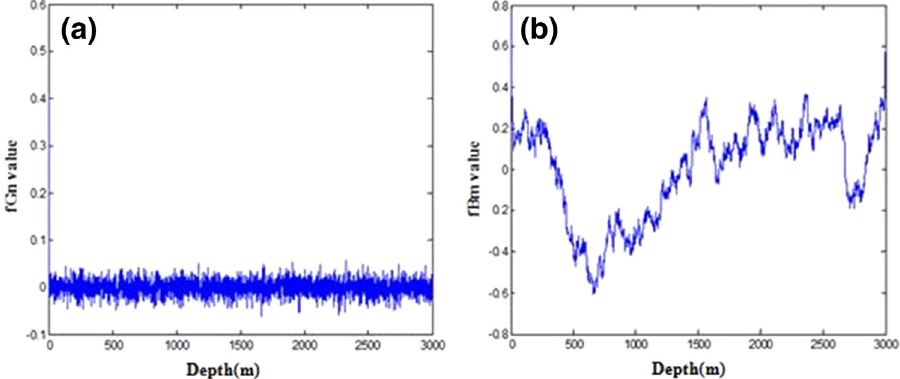
Fig. 1 Koch snowflake curve as one of the exact